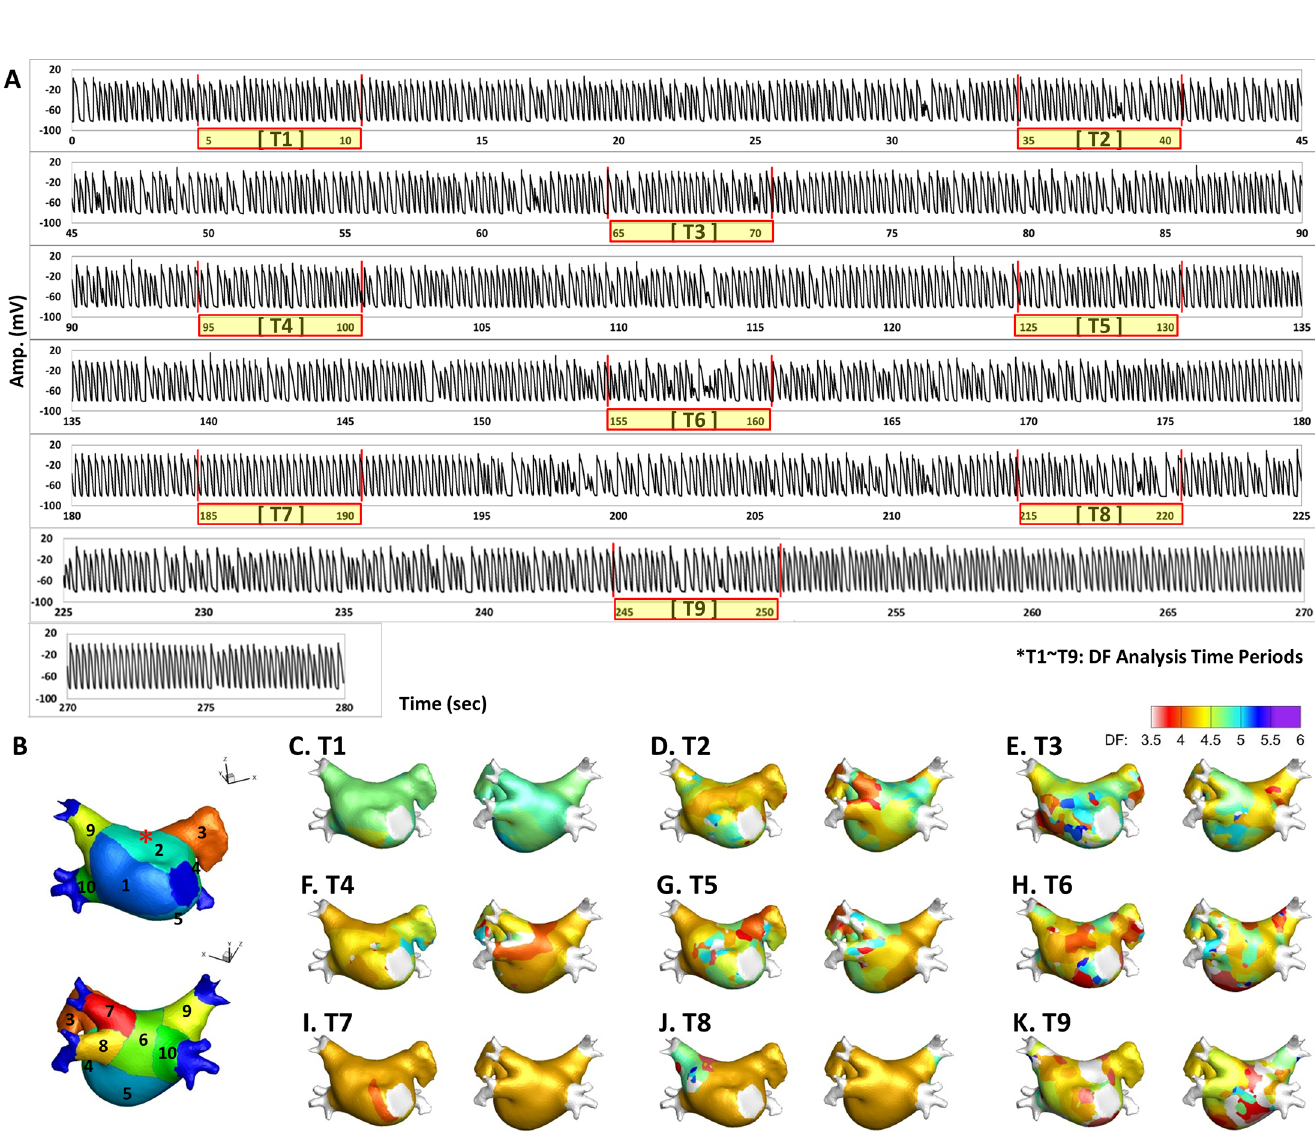
Fig 1. A. Electrogram (EGM) of action potential (AP) tracing for a total of 280 seconds and nine periods of DF analysis (T1 – T9; 6 seconds in each period). B. Ten anatomical sections of the LA geometry. Asterisk: the node where AP tracing in panel A was acquired. C~K. Spatiotemporal changes of DF maps in a representative patient ’ s LA (T1 –